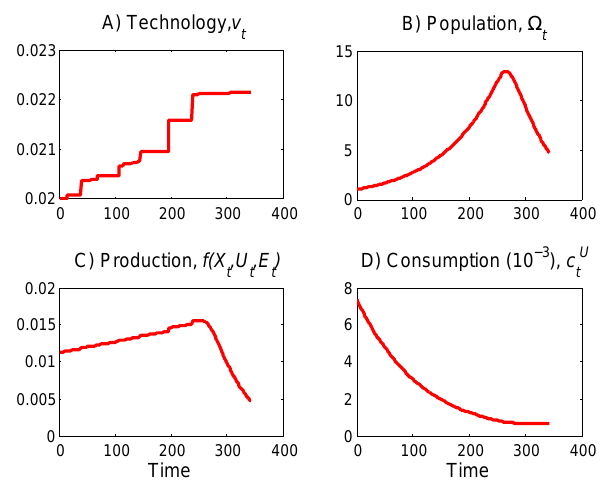
Figure 2. The co-evolution of technology, population, produc- tion and consumption per capita under a modest rate of success ( γ = 0.10). The population growth rate threshold η = 0.10. Ran- domness in technological rates of success is assumed to be gamma, distributed with mean γ and variance 100 γ 2